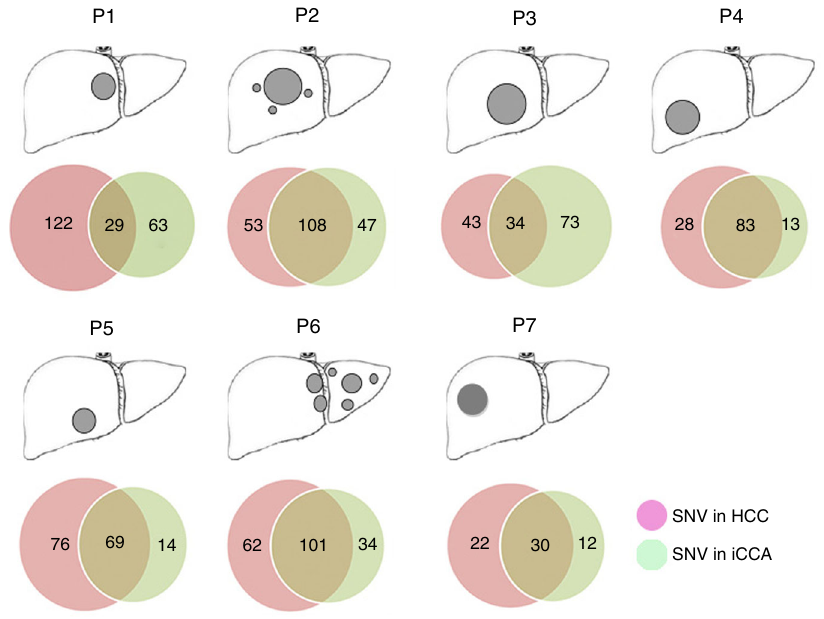
Fig. 3 Distribution of nonsynonymous SNVs. a The cartoons of liver show the tumor sites in patients. b Venn diagrams show the relationship of nonsynonymous somatic mutations between H-ChC component (red circle) and iCCA component (green circle) in every H-ChC patient. The different number represents the mumber of nonsynonymous somatic mutations for corresponding samples and the overlapped regions are ubiquitous nonsynonymous somatic mutations between two samples of same H-ChC